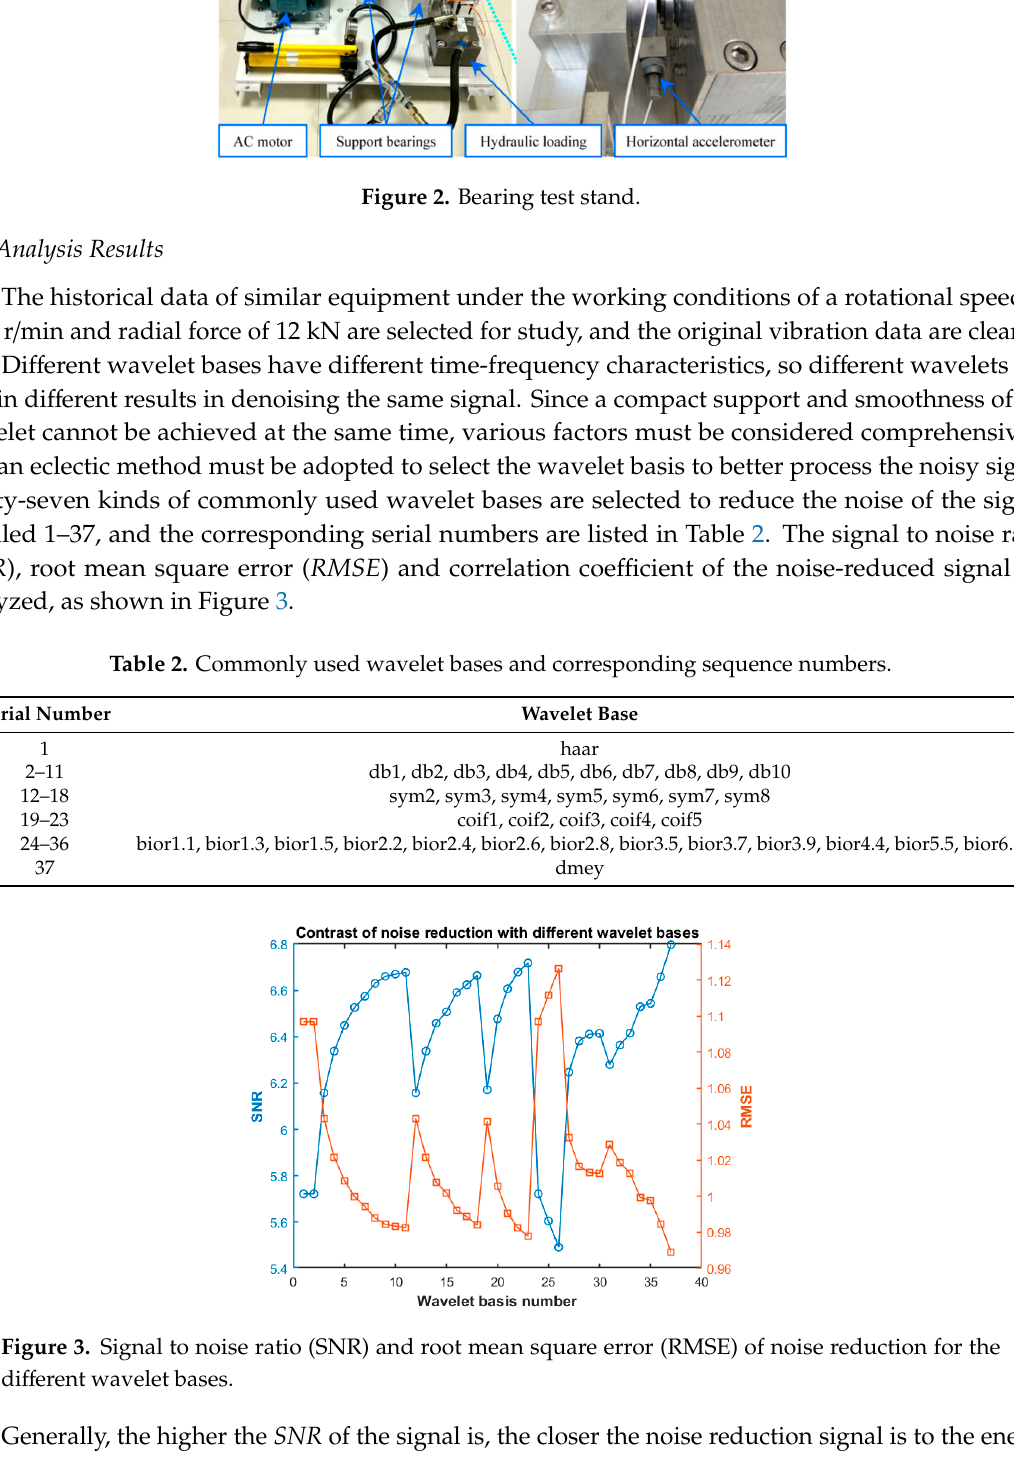
Table 2. Commonly used wavelet bases and corresponding sequence numbers.